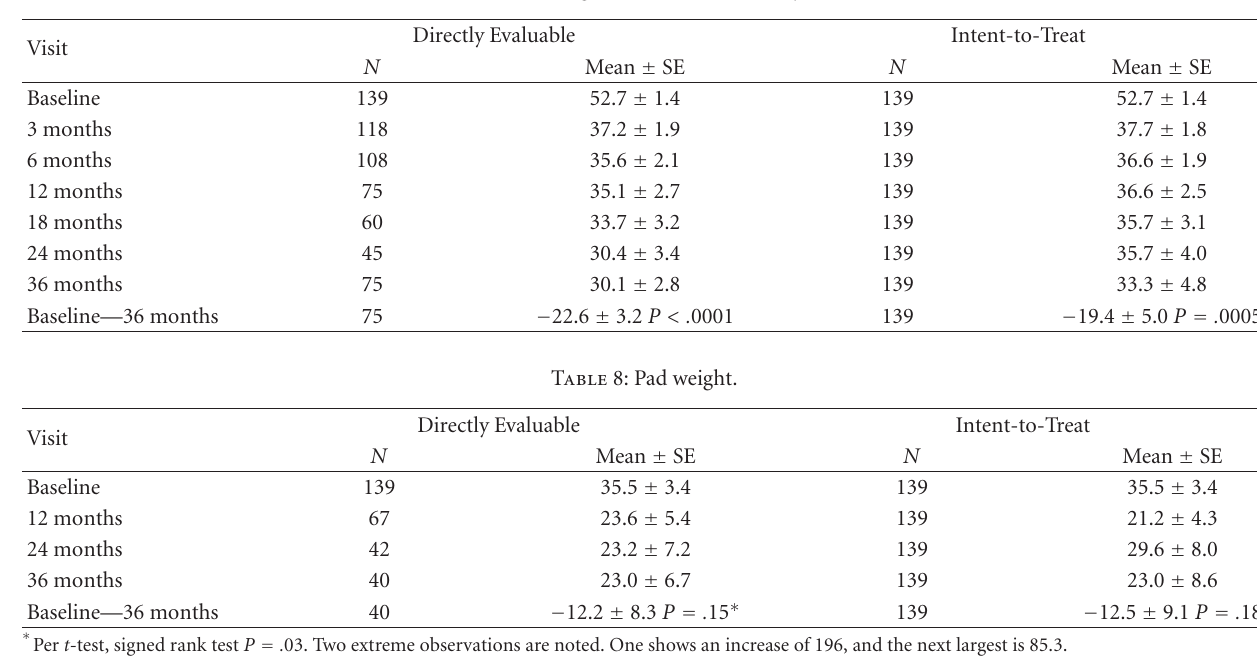
Table 7: Urogenital distress inventory-6.